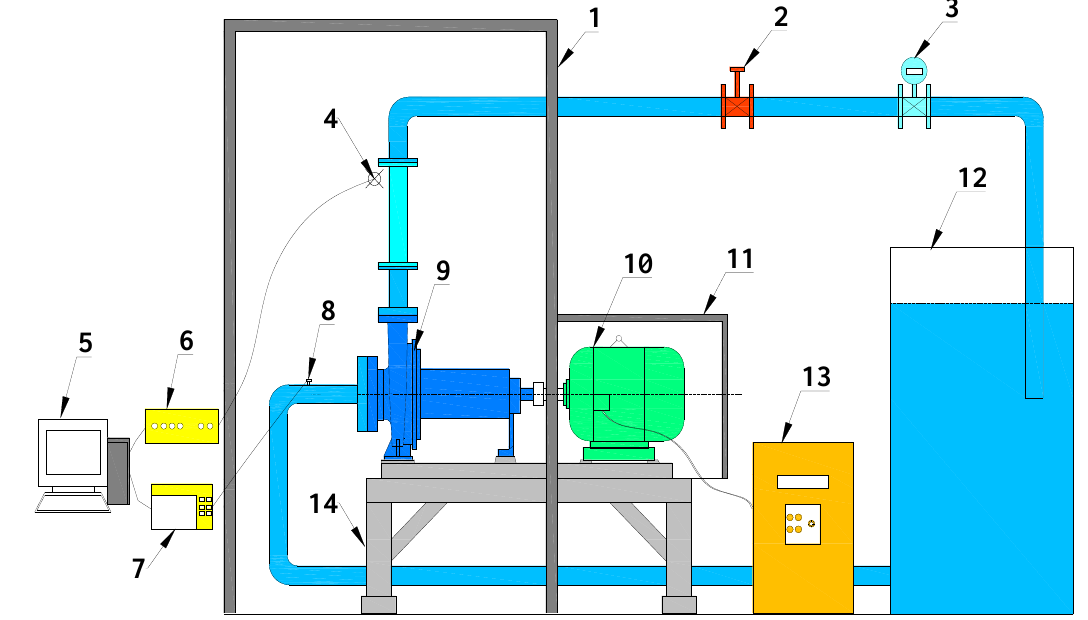
Figure 1. Layout and instrumentation of measurement system. 1: soundproof room; 2: valve; 3: flow